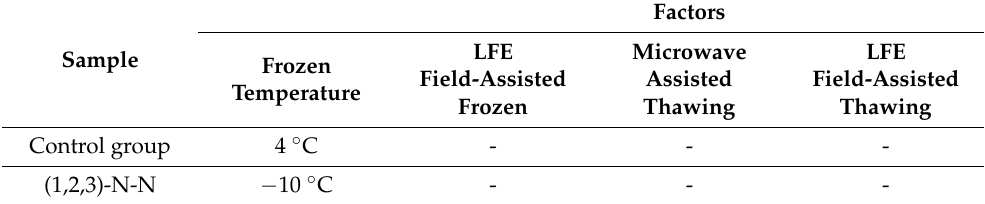
Table 2. Sample coding